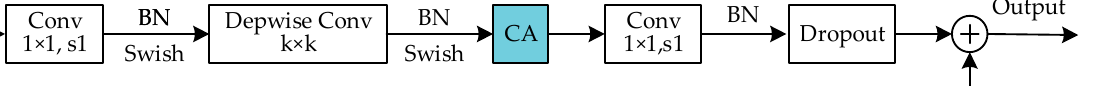
Figure 6. The improved MBConv schematic diagram. Note: ⊕ stands for channel-level addition.